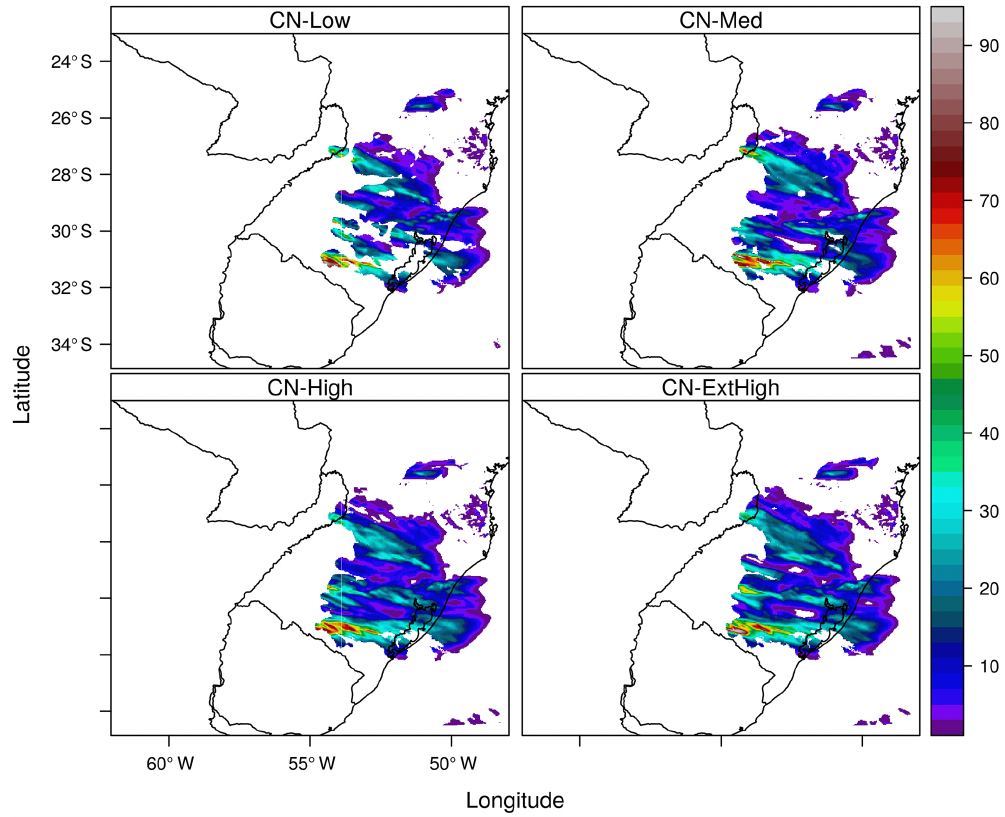
Figure 6. Accumulated precipitation produced by the MCS for CN-Low, CN-Med, CN-High and CN-ExtHigh